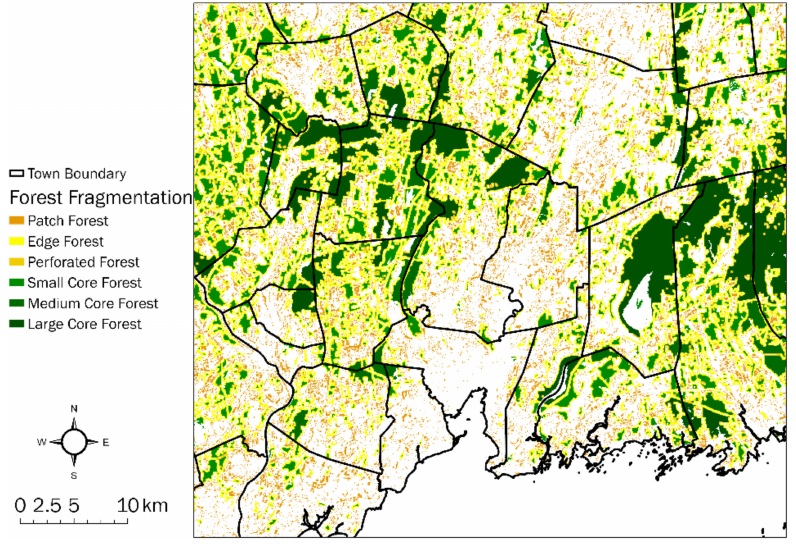
Figure 4. Central shoreline area of Connecticut showing forest fragmentation model results. White areas are non-forest.